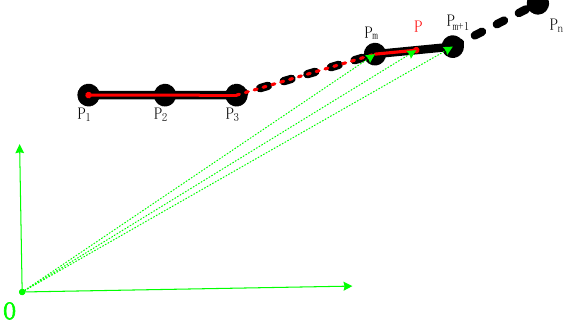
Figure 4. Schematic diagram of completed line calculation